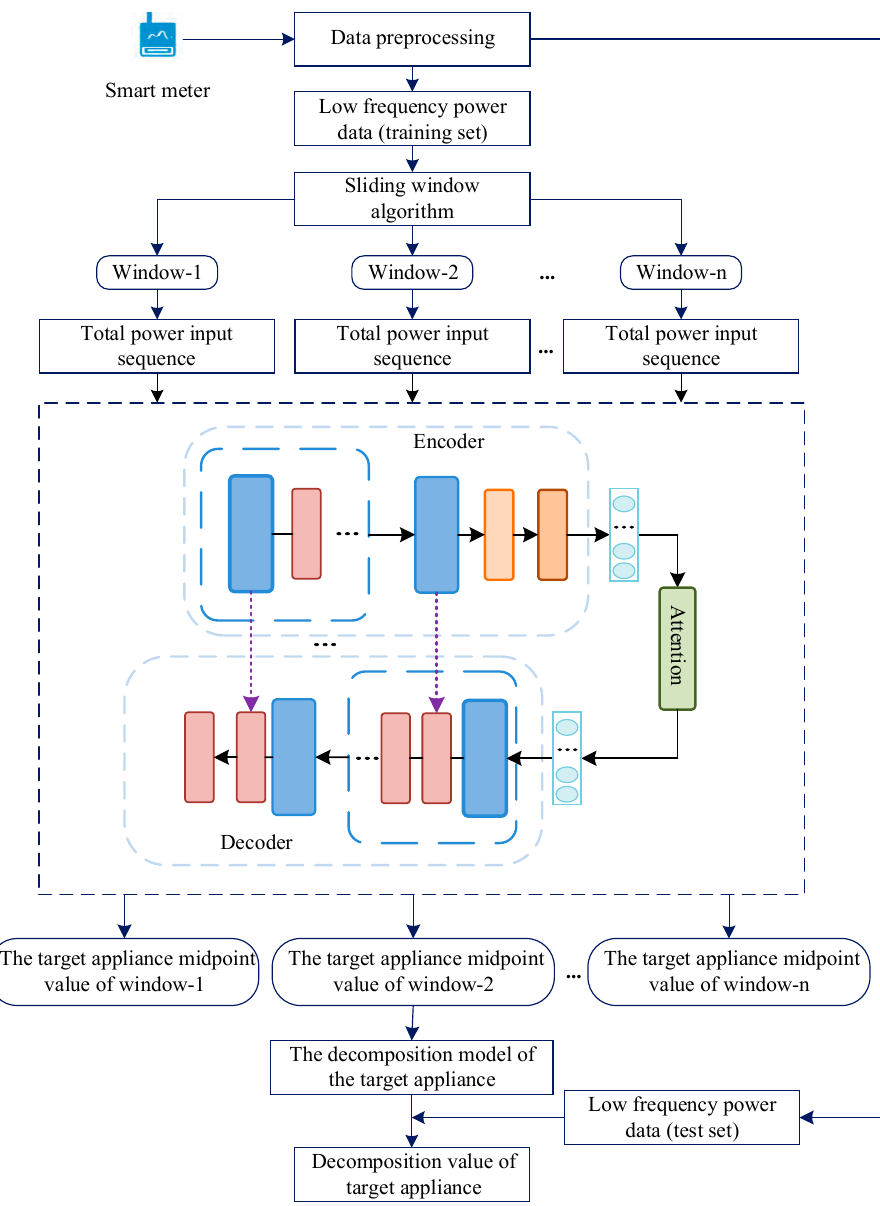
Figure 1. Flow chart of load decomposition in this study.